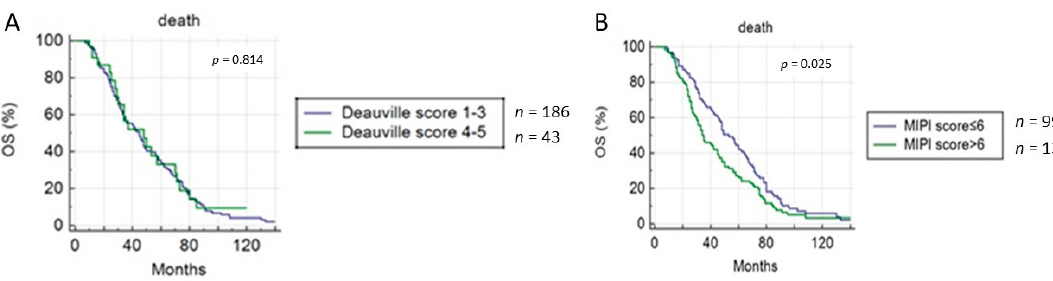
Figure 5. Overall survival (OS) curves according to end-of-treatment PET/CT results using ( a ) Deauville criteria and ( b ) MIPI score. Table 3. Univariate and multivariate analyses for PFS and OS.